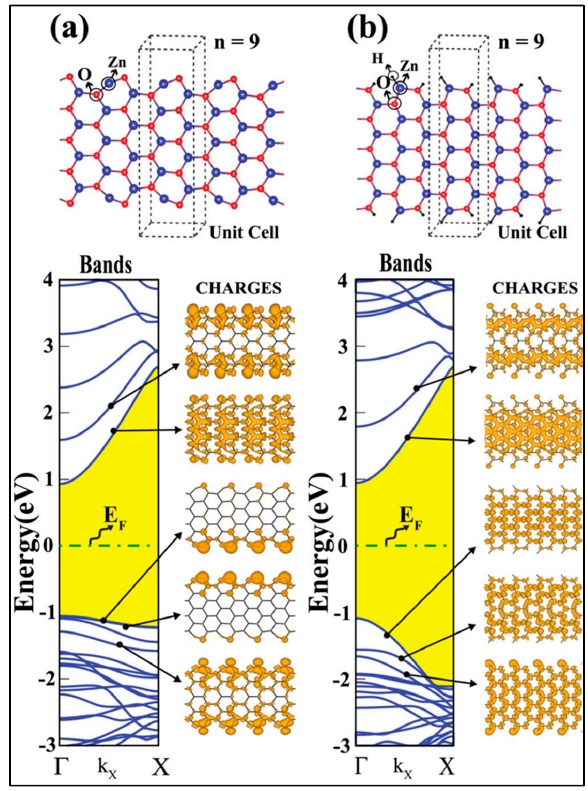
Figure 7. Lattice and electronic structure of bare ( a ) and hydrogen-passivated ( b ) armchair nanoribbons a-ZnO (with unit cell comprising n = 9 Zn–O atom pairs). Energy band structure and charge-density isosurfaces of selected states are calculated correspond to bare and hydrogen-passivated nanoribbons. Blue, red, and black balls represent Zn, O, and H atoms, respectively. Unit cells are highlighted by dashed lines. Reprinted with permission from Reference [6]. Copyright © (2009) American Physical Society.